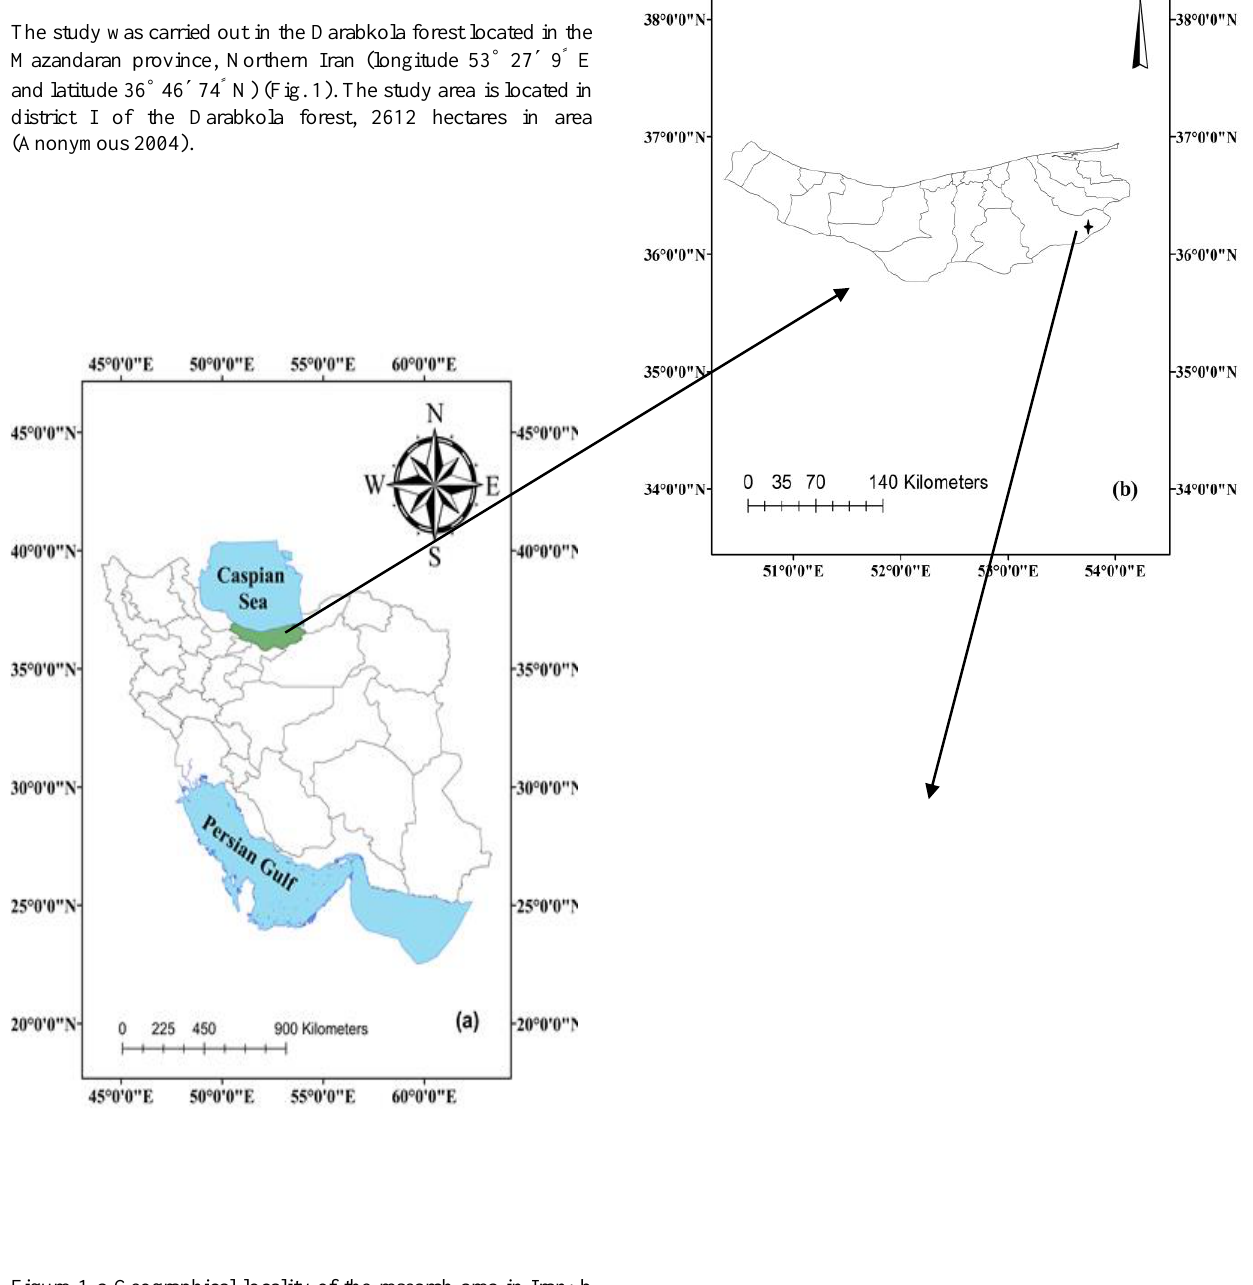
Figure 1 a Geographical locality of the research area in Iran; b Study area in Mazandaran Province; and c location of Sampled Plots on RGB color extracted from Pleiades